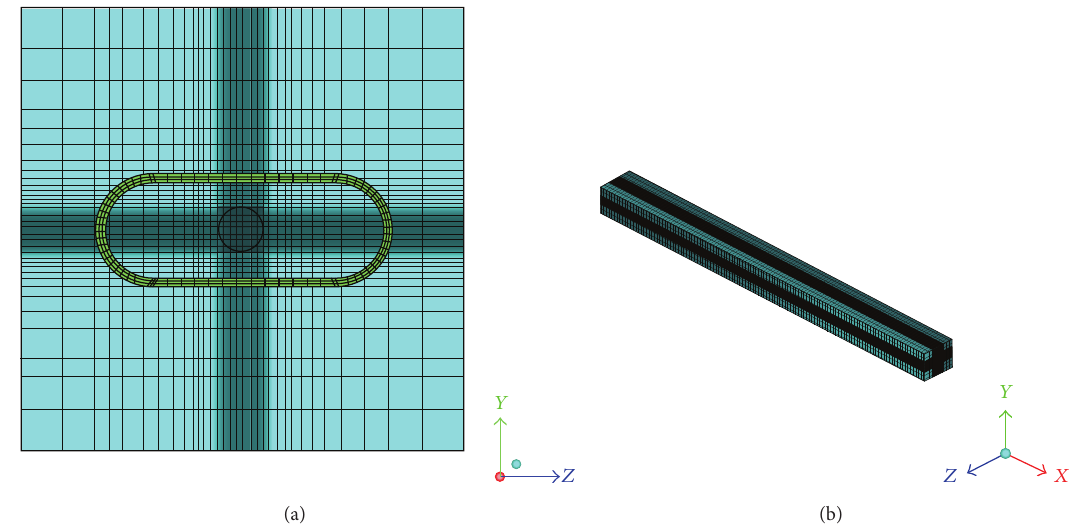
Figure 12: Three-dimensional model of expanding tube (front view (a) and isotropic view (b)).